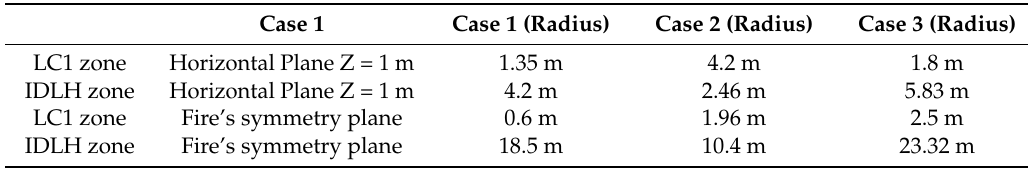
Table 1. LC1 and IDLH radius for Case 1, 2, and